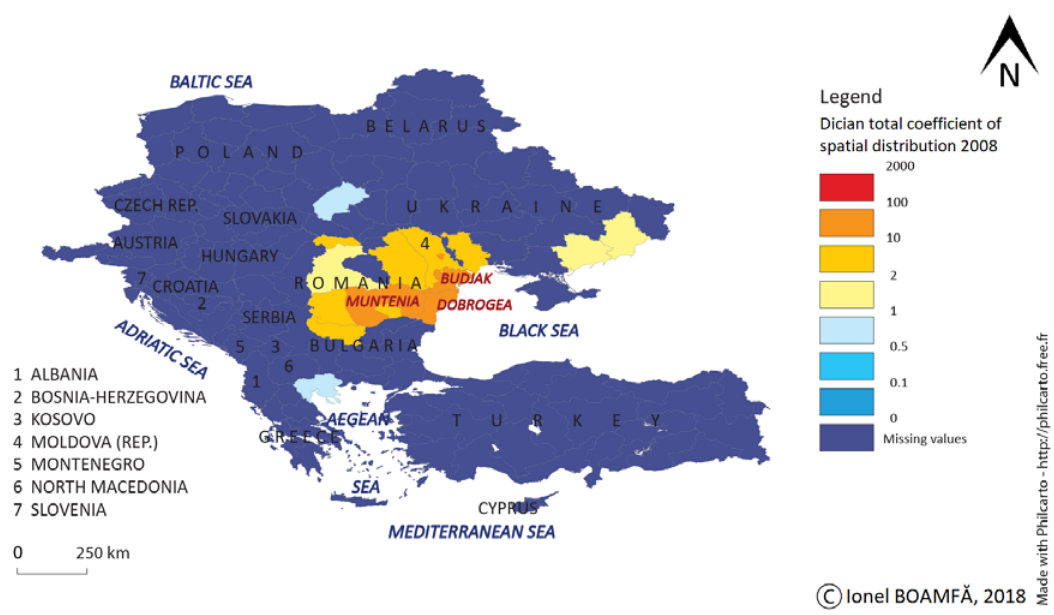
Figur e 6 . G eographical repartition of the anthroponym Di cian. Coef. of spatial